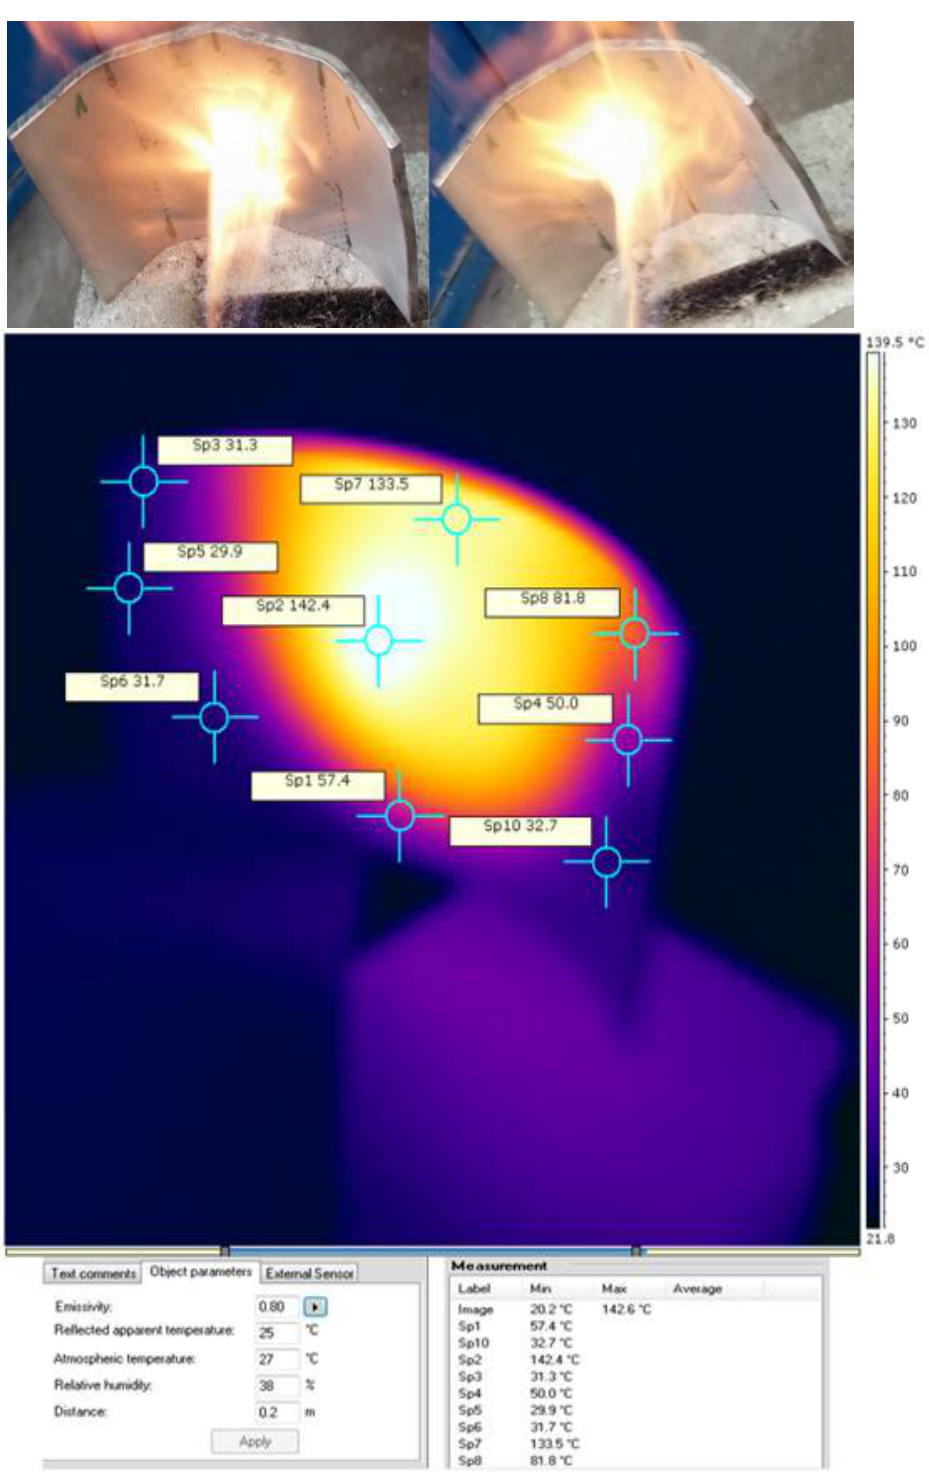
Figure 24. Thermal study for target C (front view) direct contact with the flame at a temperature above 150 °C. Plate thickness: 4 mm, material: 316 L stainless steel, holding time: 4 min, and a concave shape.